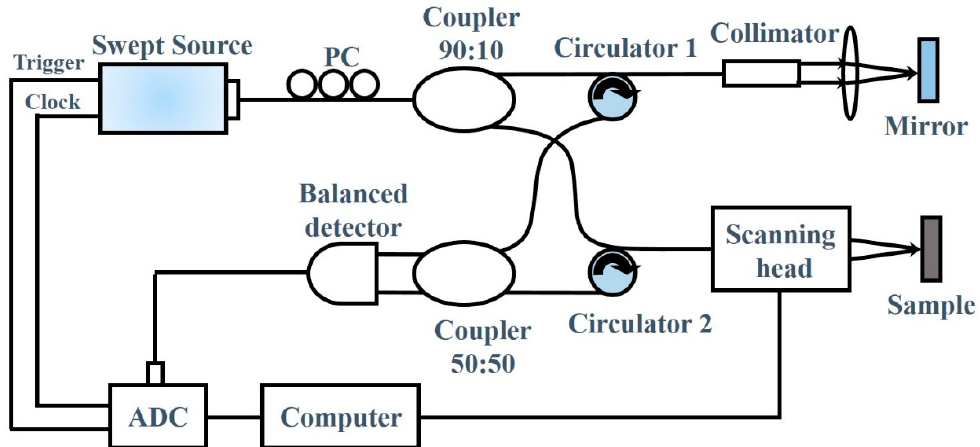
Figure 1. Schematic of the swept source optical coherence tomography (OCT) system, ADC: analog to digital converter, PC: polarization controller.